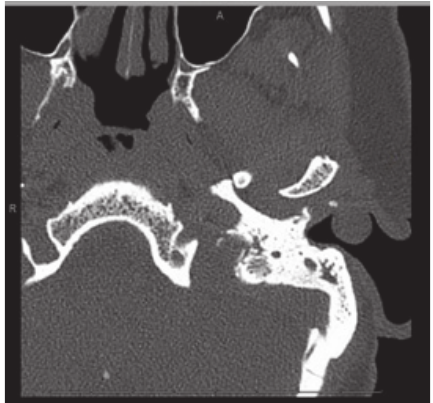
Figure 1: A bluish lesion is seen in the external auditory canal inferiorly, partially blocking the canal lumen. Figure 2: CT of the temporal bones shows a well-defined cystic lesion originating from the anterolateral portion of the left external auditory canal. The lesion has no deep extension, does not show any bone erosion, and does not involve the middle ear cleft.